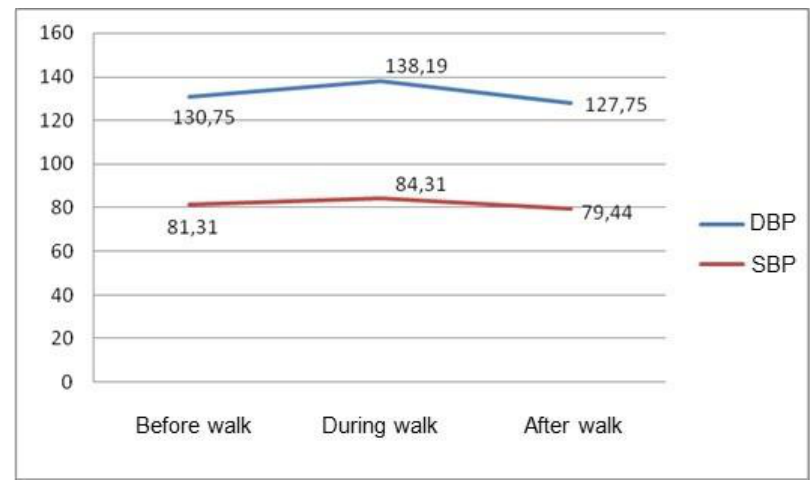
Figure 4 - Variation of SBP and DBP before, during and after a